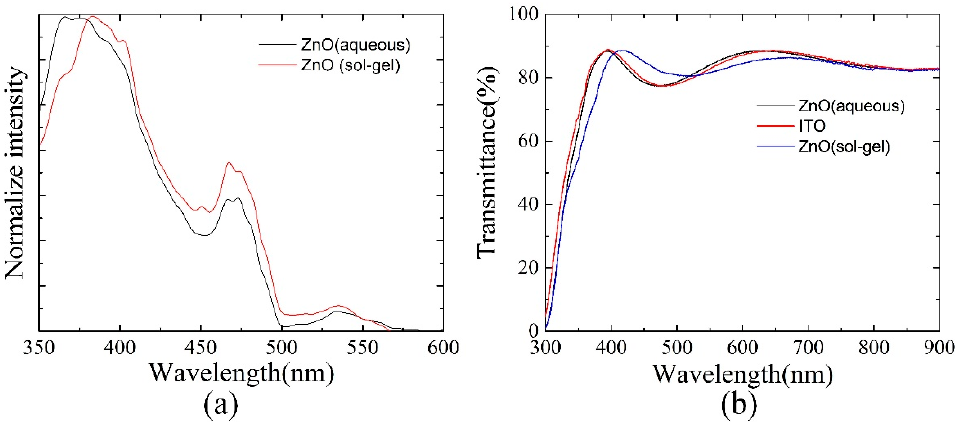
Figure 4. ( a ) Photoluminescence spectra of the ZnO film using aqueous solution or sol-gel solution methods under 325-nm light excitation, respectively; ( b ) transmittance spectra of ITO, ITO/ZnO(aqueous), and ITO/ZnO(sol-gel).